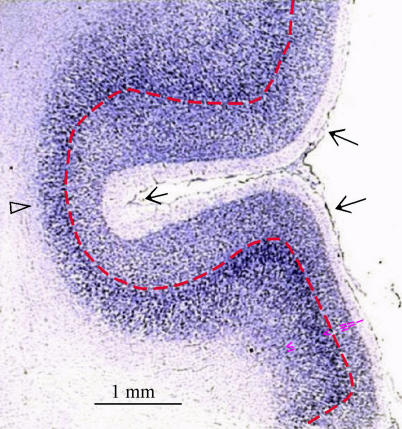
Effect of Cortical Folding on Absolute and Relative Thickness of Cortical LayersCoronal section through medial prefrontal cortex of a rhesus monkey brain in the anterior cingulate. Note the expanded deep layers (below dotted line demarcating the upper boundary of cortical layer V) in the gyral regions (large arrows), contrasted by reduced thickness of the deep layers at the bottom of the cingulate sulcus (arrowhead) and the expanded layer I (small arrow) in comparison with layer I in gyral cortex. The brain section was immunoreacted for NeuN, a neuronal marker (brown), and then stained for Nissl (blue).